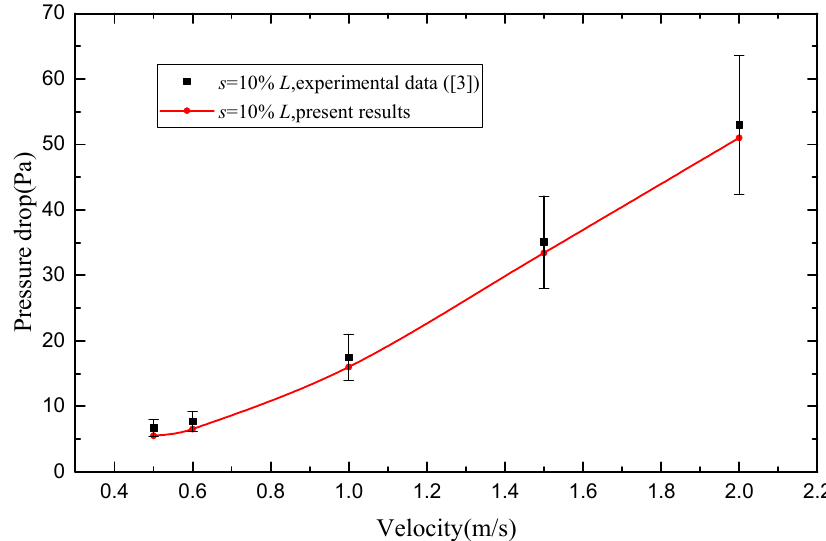
Figure 5. Comparison between the present numerical simulations and the experimental results obtained by Duan and Muzychka [3].